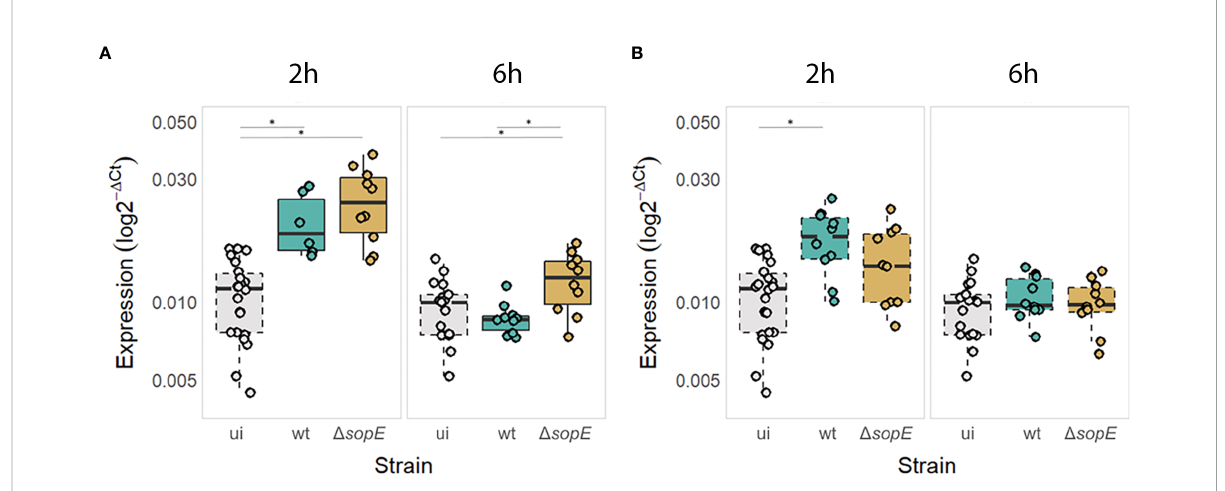
FIGURE 3 MAP1LC3B gene expression is increased at the early stages of Salmonella infection but decreased at later stages in a SopE-dependent manner in Salmonella- containing epithelial cells (A) but not in bystander cells (B) . MAP1LC3B expression levels expressed as log2- D CT so that uninfected cells (ui) are also displayed. Continuous borders = infected cells containing Salmonella (wt or mutant) and dashed borders = bystander epithelial cells not containing Salmonella or uninfected cells. *